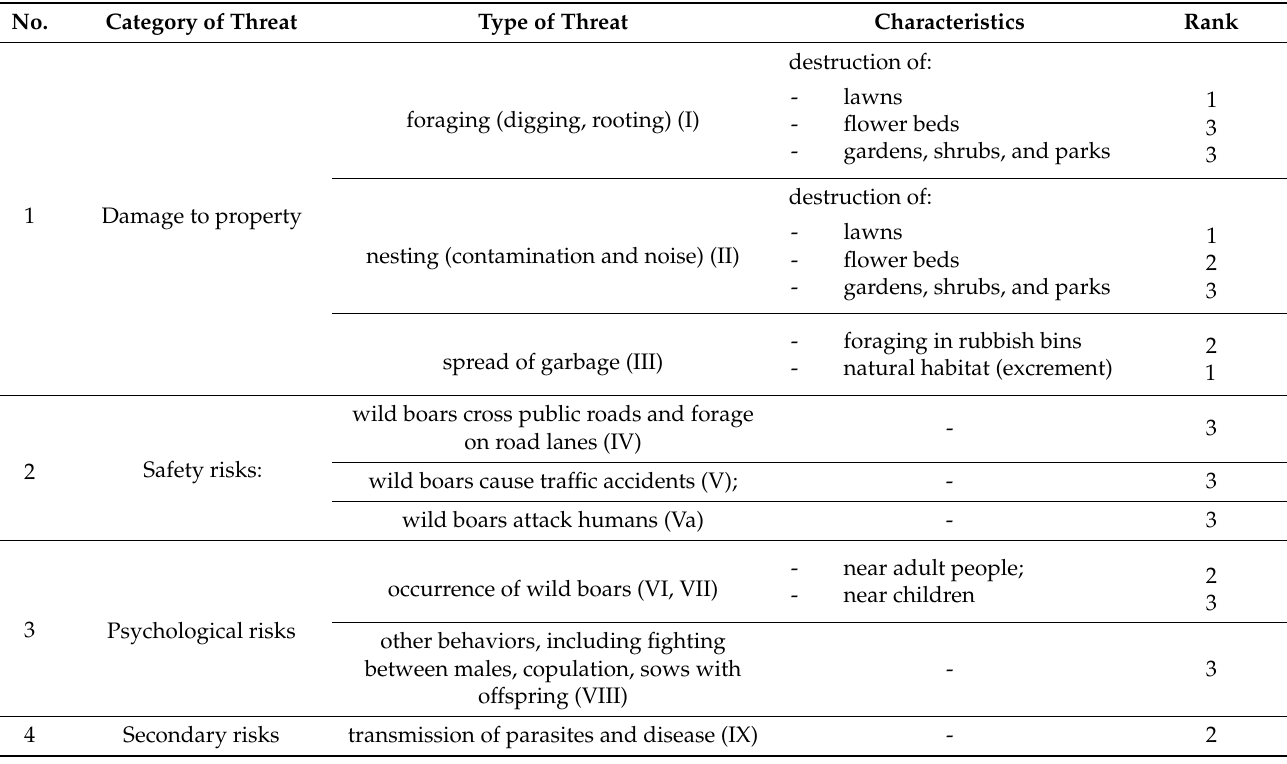
Table 2. Categories of socio-spatial conflicts involving wild boars in